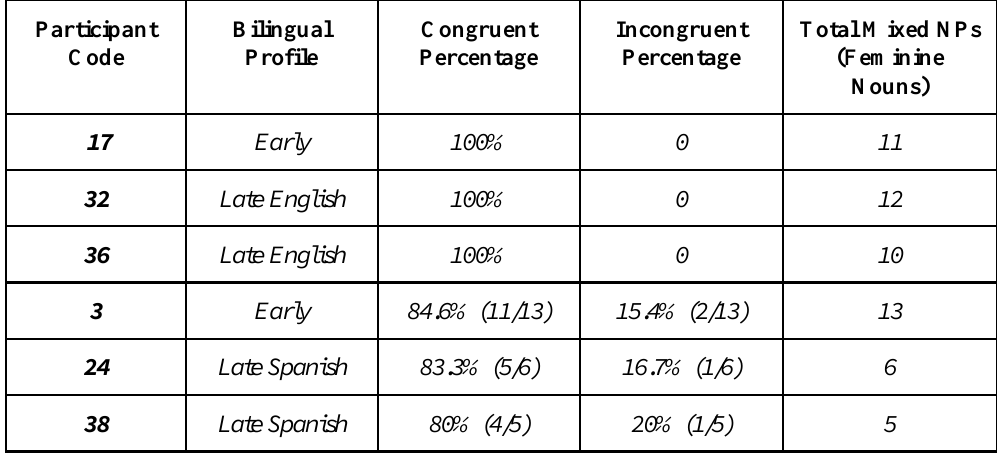
Table 11. Percentage and number of mixed NPs produced by participants (regarding only stimuli with Spanish feminine translation